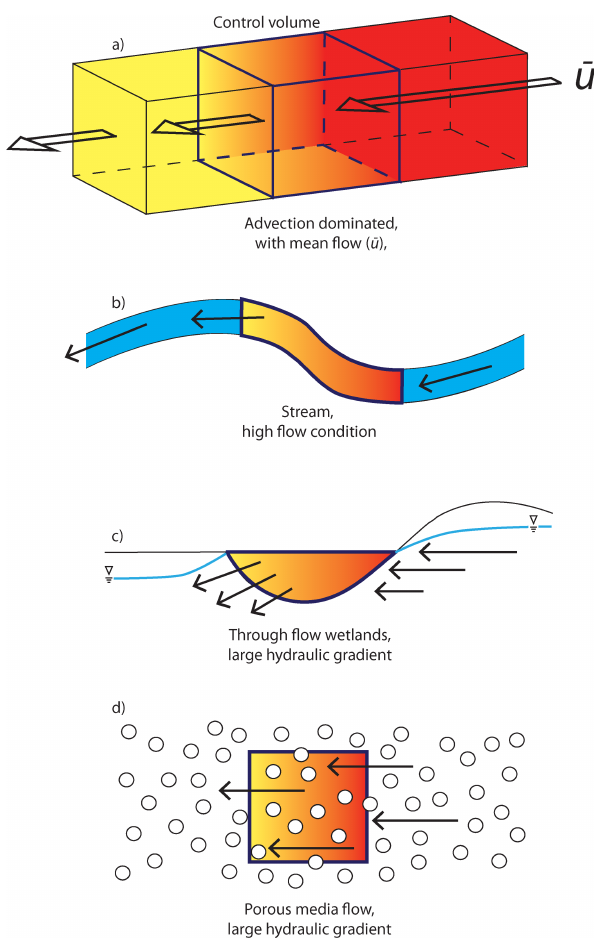
Fig. 2. Regime I: (a) transport and fluxes of chemical B across hydrologically or hydraulically connected elements are dominated by advection. Examples of this regime are a river under high flow conditions (b) , a wetland with groundwater throughflow under a large hydraulic gradient (c) and porous media flow under a large hydraulic gradient (d) .